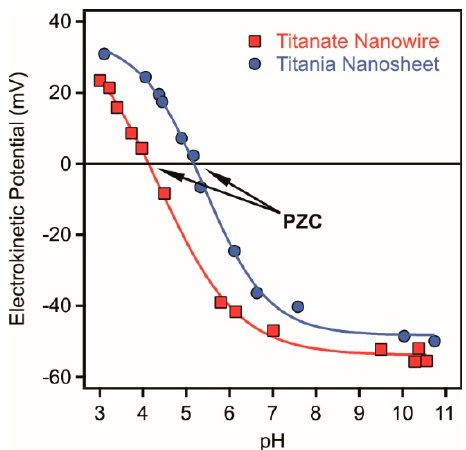
Figure 1. Electrokinetic potentials of titanate nanowires (squares, PZC 4.1) and titania nanosheets (circles, PZC 5.2) as a function of the pH at 1 mM ionic strength. The data were taken from References [56,59].